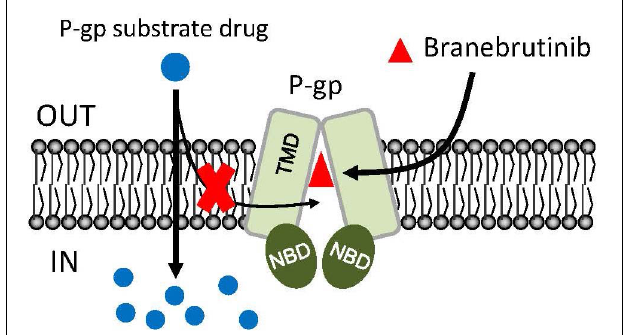
FIGURE 7 | Simplified schematic of branebrutinib resensitizing P-glycoprotein (P-gp)-overexpressing multidrug-resistant cancer cells to anticancer drugs by blocking the drug efflux function of multidrug transporter. The intracellular concentration of a P-gp substrate drugs (blue circles) in P-gp-overexpressing cells is significantly reduced by the drug efflux function of P-gp. However, in the presence of branebrutinib (red triangles), branebrutinib outcompetes the binding of P-gp substrate drug to the same drug-binding pocket of P-gp and consequently restores the intracellular accumulation and efficacy of substrate drugs in P-gp-overexpressing multidrug-resistant cells.